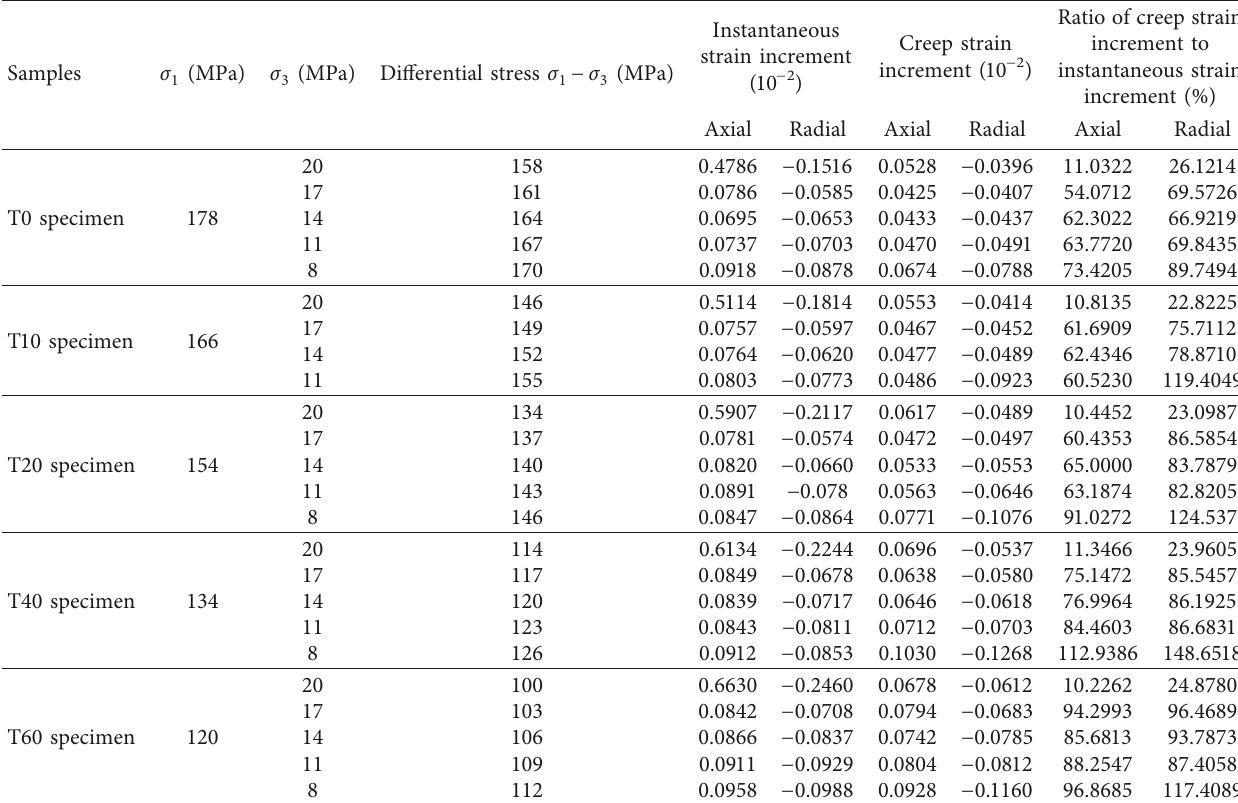
Table 3: Triaxial unloading creep test results.